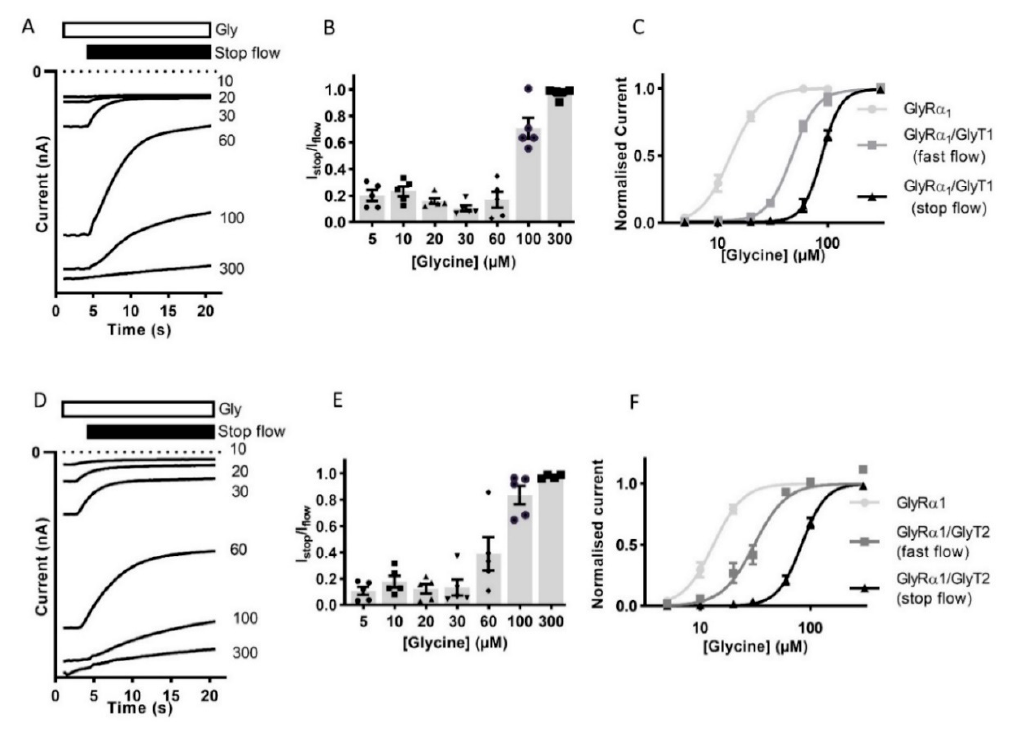
Figure 2. Reduction of current amplitude by GlyTs in co-expressed cells is glycine concentration dependent. Glycine concentration-dependent modulation of GlyRs by GlyTs. ( A , D ) Raw I stop current trace examples of cells expressing GlyR α 1 / GlyT1 or GlyR α 1 / GlyT2 in the presence of varying concentrations of glycine. ( B , E ) I stop / I flow ratios for varying concentrations of glycine. ( C , F ) Stop-flow and fast-flow (same cell) glycine dose-responses for co-expressed cells. Currents were normalised to I max and fit to the Hill equation. Symbols are mean ± SEM ( n = 5). Table 2. Stop-flow and fast-flow glycine EC 50 in GlyR α 1 and GlyR α 1 / GlyT co-expressed